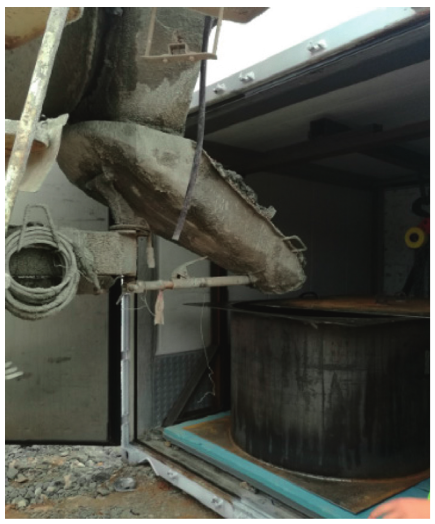
Figure 4: Concrete pouring